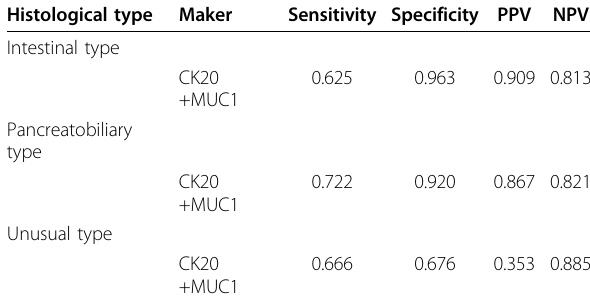
Table 4 Sensitivity, Specificity, Positive Predictive